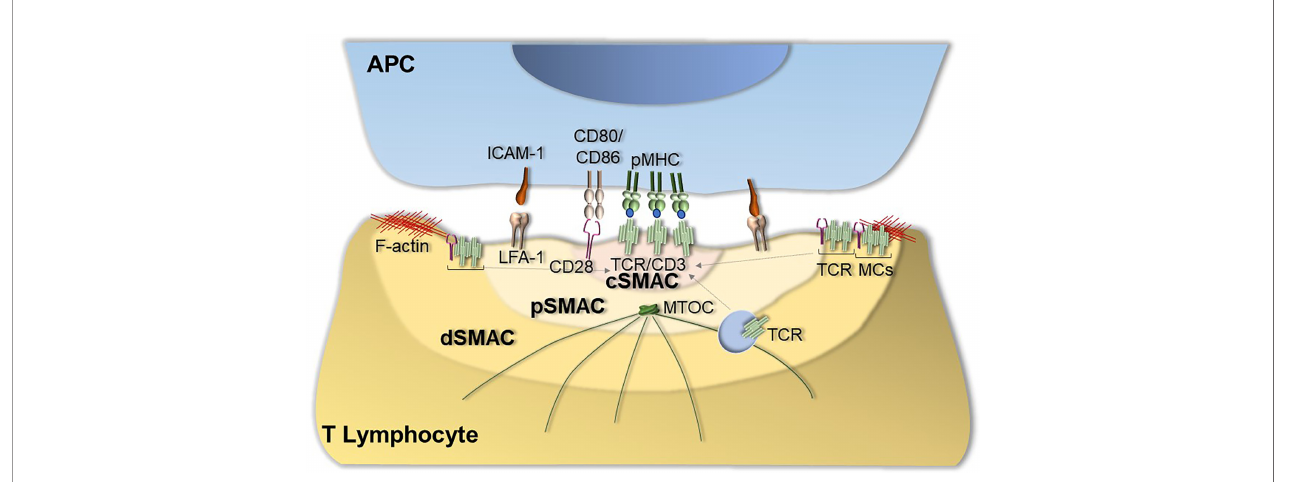
FIGURE 1 | Immunological synapse assembly. The canonical IS shows a well-organized bull ’ s eye architecture that features the central supramolecular activation cluster (cSMAC) characterized by the presence of TCRs and TCR-associated proteins such as the co-stimulatory receptor CD28, the peripheral SMAC (pSMAC) enriched in the integrin LFA-1 and the distal SMAC (dSMAC) enriched in TCR-CD28 microclusters (TCR MCs) that move centripetally towards the cSMAC driven by F-actin. IS assembly is also coordinated by cytoskeletal dynamics that allow for centrosome translocation toward the IS as well as for the directional vesicular traf fi cking of receptors and signaling mediators to sustain signaling at the